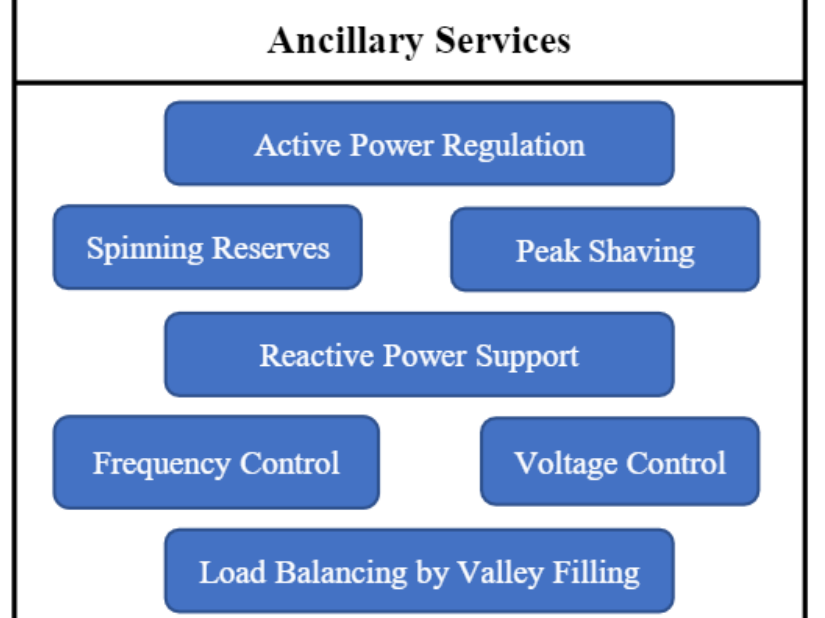
Figure 7. Potential ancillary services of EVs.